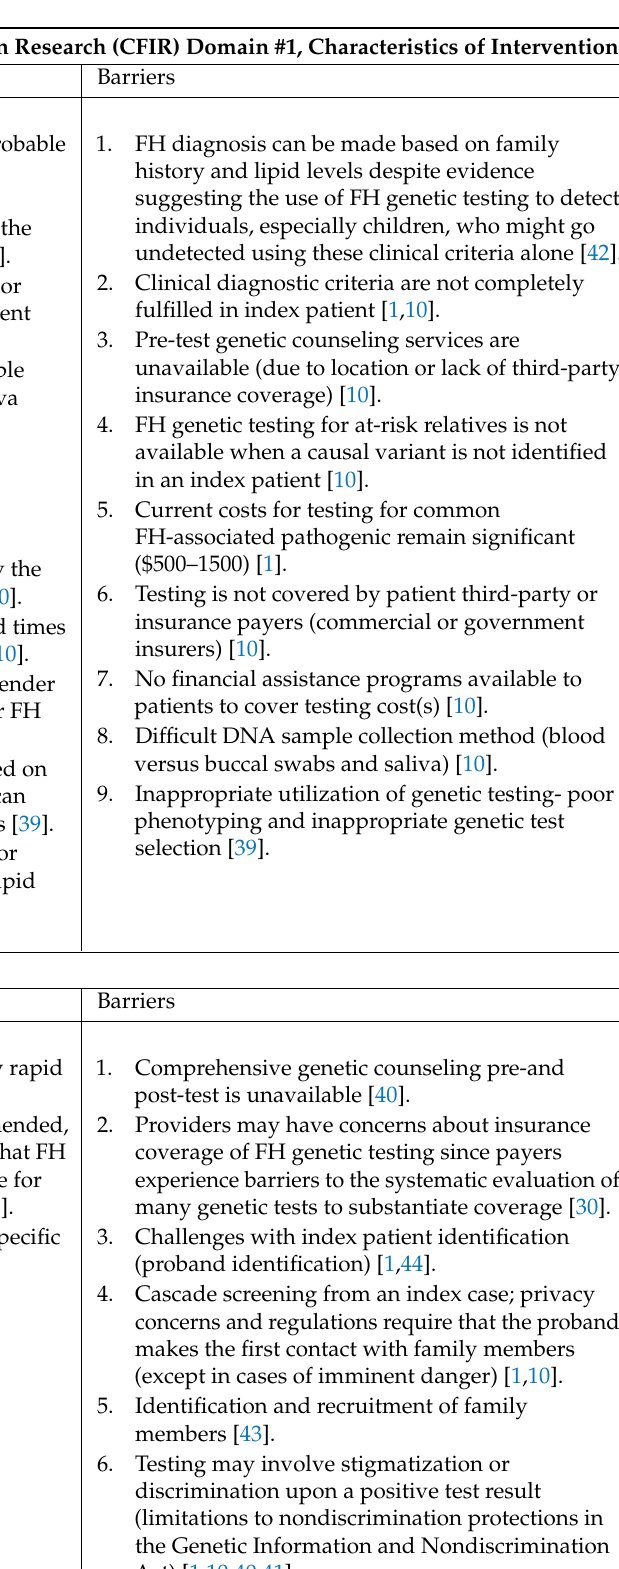
Table 3. Possible Barriers and Facilitators to Genetic Testing for Familial Hypercholesterolemia (FH) in the United